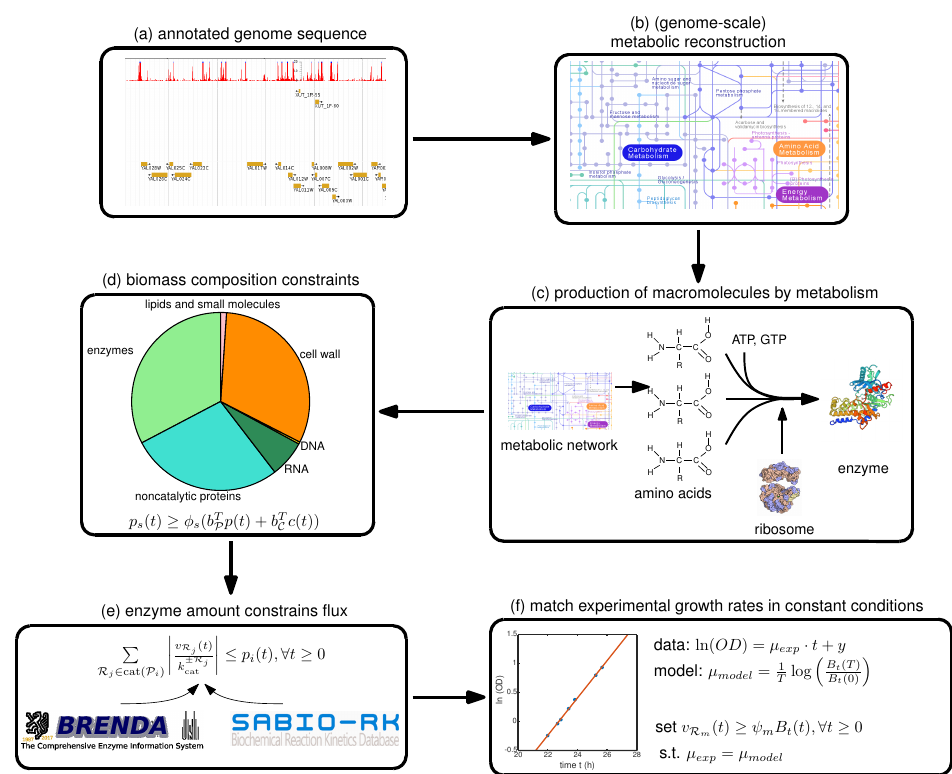
Figure 1. Protocol for generating a deFBA model. From an annotated genome sequence ( a ) of the organism of interest the metabolic network ( b ) is reconstructed following instructions in [15]. Given the gene-reaction mapping and the annotated genome sequence, the enzymes and ribosomes ( c ); and their synthesis reactions are added to the stoichiometric matrix (see Section 4). Next, the biomass composition constraints ( d ) should be set up using information from the biomass objective function of the metabolic network model (see Section 5). Then reaction turnover rates ( e ) sourced from literature and online databases should be added (see Section 6). Lastly but most importantly, the deFBA model should be fine tuned to match experimental growth rates ( f ) obtained in the laboratory (see Section